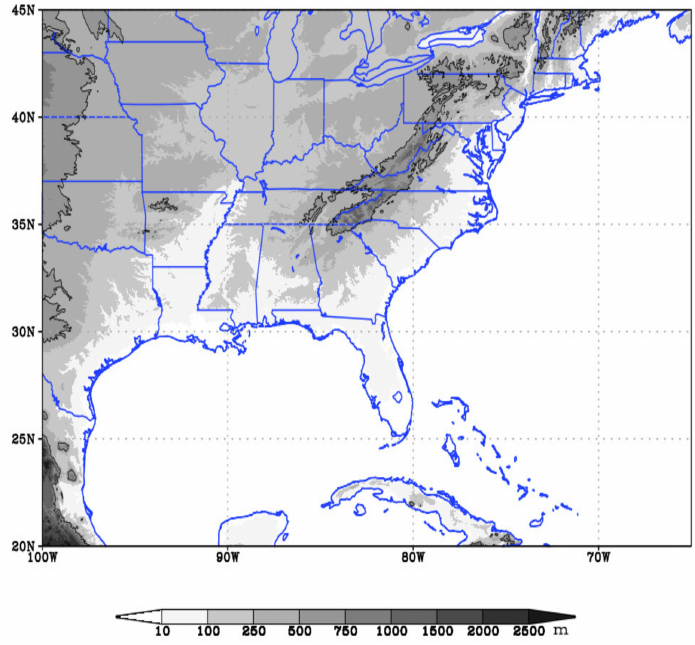
Figure 1. Terrain heights (m) in the Southeastern United States and the adjacent region based on the United States Geological Survey (USGS) observation. Black contours show terrain heights of 500